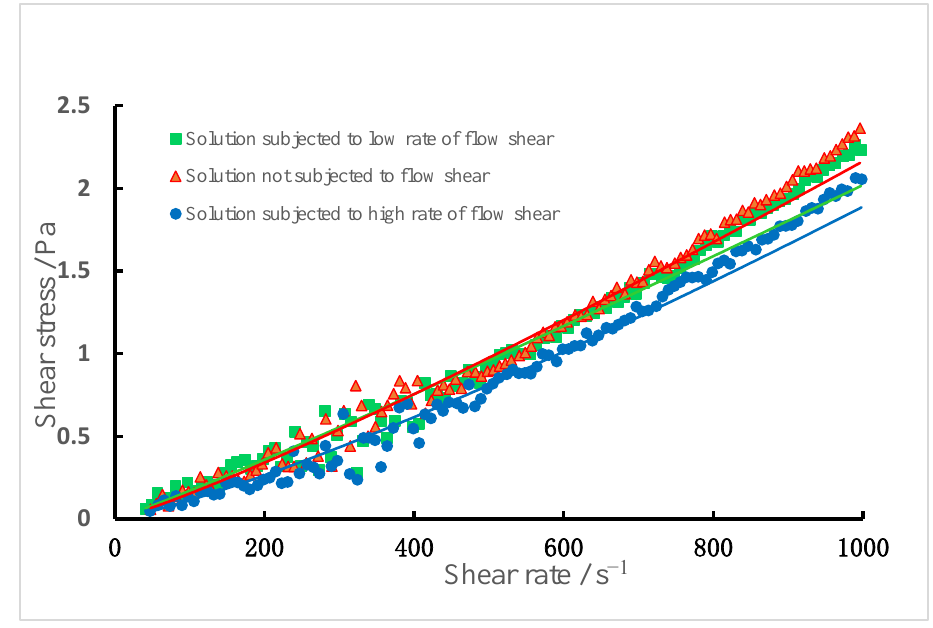
Figure 8. Rheological characteristic curves of the drag reducer solutions with shear rate. By comparing the three curves of shear stress with shear rate, it is found that the three samples were similar in rheological behavior, all showing rheological features of power-law fluid (typical non-Newtonian fluid). When affected by shear flow, the drag reducer solution would turn weaker in power-law behavior and tend to be more like Newtonian fluid (fresh water). The more serious the shear failure of the solution, the weaker the non-Newtonian feature of the solution would be. Correspondingly, the solution decreased in viscosity and became weaker in viscoelasticity.